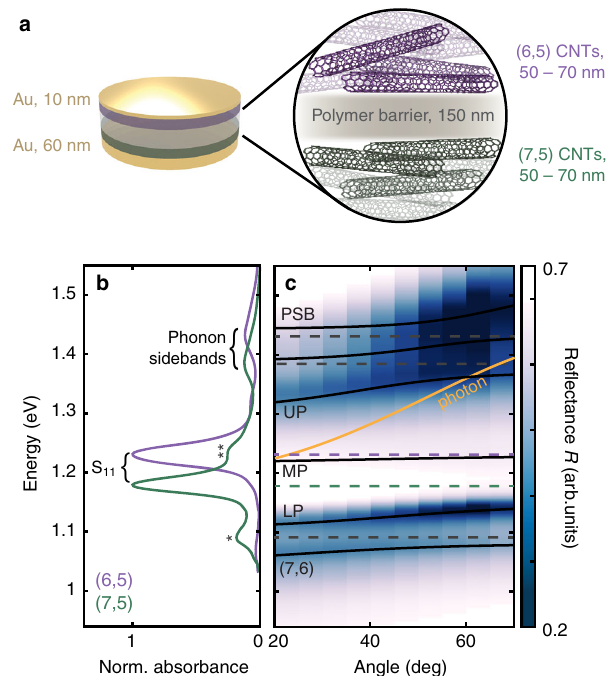
Fig. 1 | Structure of the microcavity and steady-state spectra. a Schematic illustration of the mixed (6,5)/(7,5) carbon nanotube (CNT) microcavity investi- gatedinthiswork. b LinearabsorptionspectraoftheuncoupledCNTsmeasuredin 1,2-dichlorobenzene, each normalized to the S 11 peak maximum. The two peaks labeledwithasterisksdenoteminorimpuritiesinthe(7,5)CNTsfromresidual(7,6) (*, 1.09 eV) and (6,5) (**, 1.23 eV) chiralities 70 . c Angle-dependent re fl ectance ( R ) spectra of the microcavity shown in a . Dashed lines illustrate the uncoupled CNT state energies as shown in b , where the energy levels of the two most intense transitions, i.e ., those that couple most strongly to light, are highlighted in purple ((6,5)) and green ((7,5)). Black solid lines are coupled oscillator model fi ts to the measured spectra, and the yellow solid line shows the cavity dispersion pro fi le determined from the model (see Supplementary Note